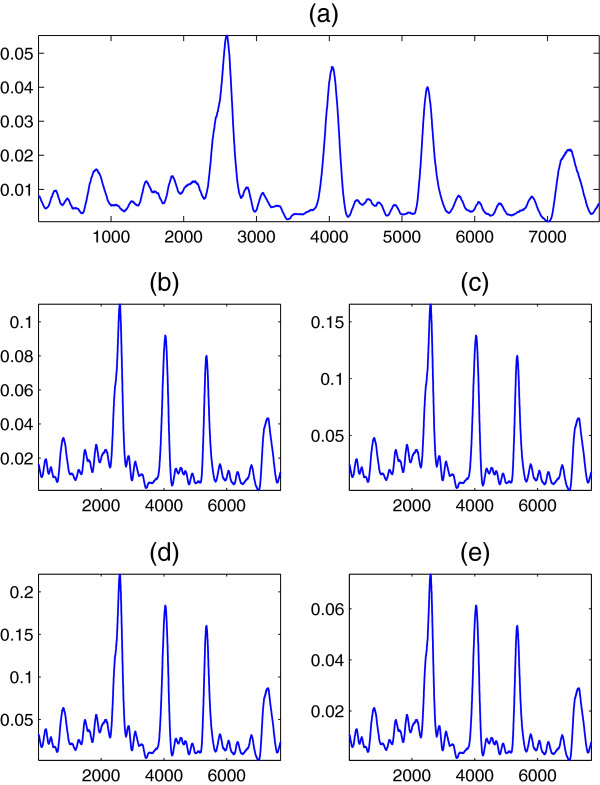
DNA spectrumS~d(n)withh~set to a Blackman window at
R
= 3 of the DNA sequence F56F11.4 when (a) Voss, (b) tetrahedral, (c) quaternion, (d)
Z
-curve, and (e) simplex mappings are used.